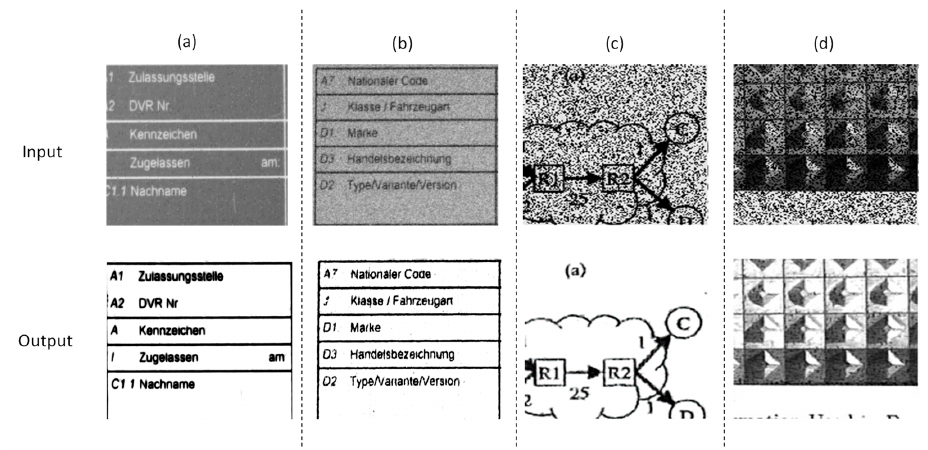
Figure 8. Samples (for illustration) of removing noise from selected natural document images.